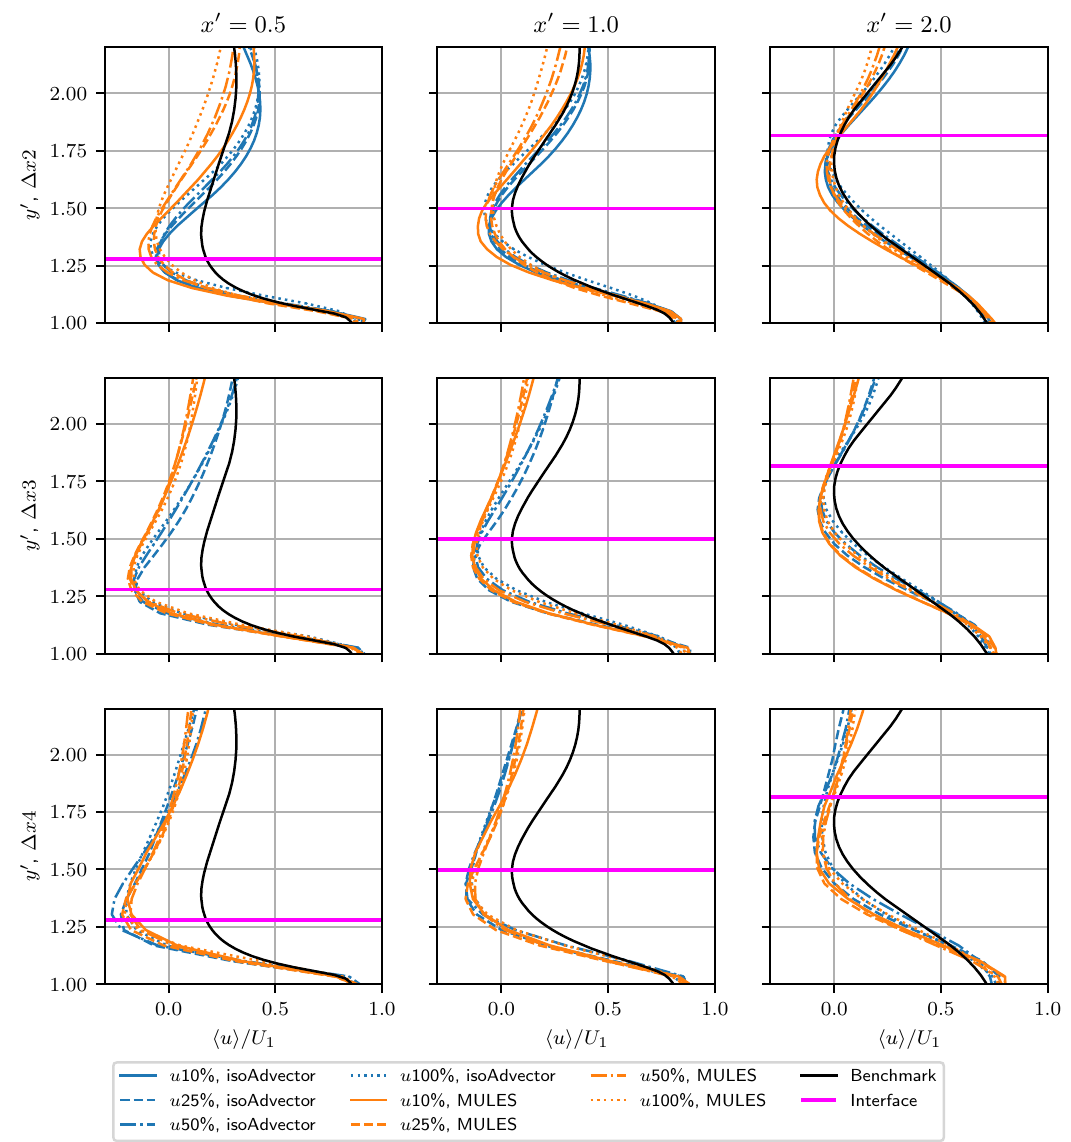
Figure 12. The profiles of (cid:104) u (cid:105) / U 1 obtained in the simulation campaign. The analysis of the velocity predictions is now concluded by considering the spanwise energy spectra of the streamwise velocity; see Figure 14. The spectra were computed at the same three [ x , y ] locations as the spanwise autocorrelation functions for the benchmark simulations. This entailed that the respective x (cid:48) values were slightly different from simula- tion to simulation. The reason for considering spanwise spectra instead of temporal was that, due to a larger amount of samples to average across, the spanwise spectra were much smoother, making it easier to distinguish the profiles from different simulations in the plots. Unsurprisingly, increased upwinding led to heavier dampening of the high-frequency fluctuations. Due to the log–log scale being used, it was actually difficult to distinguish any effects of the VoF algorithm or ∆ x , besides the fact that the frequency band of the spectrum was larger for denser meshes. One could say that for small amounts of u %, the spectrum was relatively well predicted even at ∆ x 4. Therefore, one should exercise caution when making judgements regarding the mesh resolution based on the spectrum